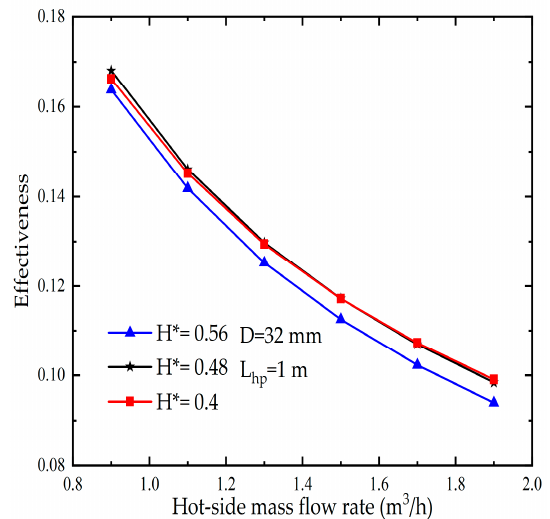
Figure 13. Comparison of minimum vapor temperature with different H ∗ . (The mass flow rates at cold side of the HPHEX is 2.9 m 3 /h.)